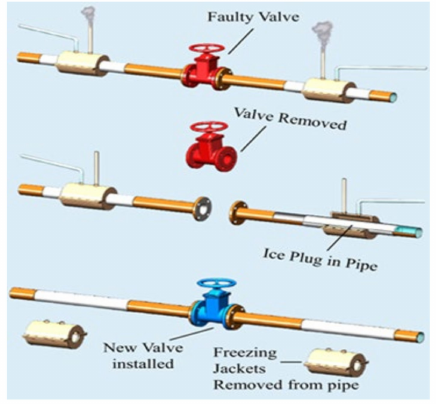
Figure 2. Replacement of a faulty